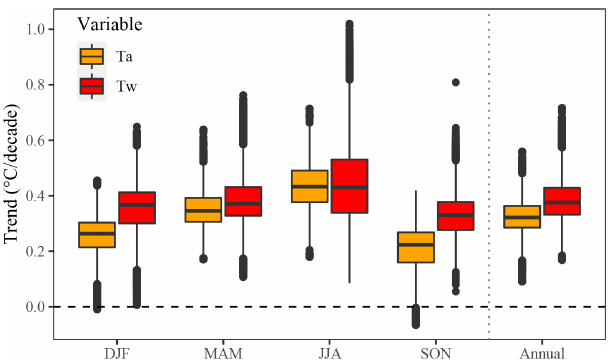
Figure 4. Distributions of seasonal and annual trends in T w and T a for all 52278 reaches over the 1963–2019 period. Sen’s slope is used as the trend value estimate (see text). This representation includes both significant and non-significant trends.